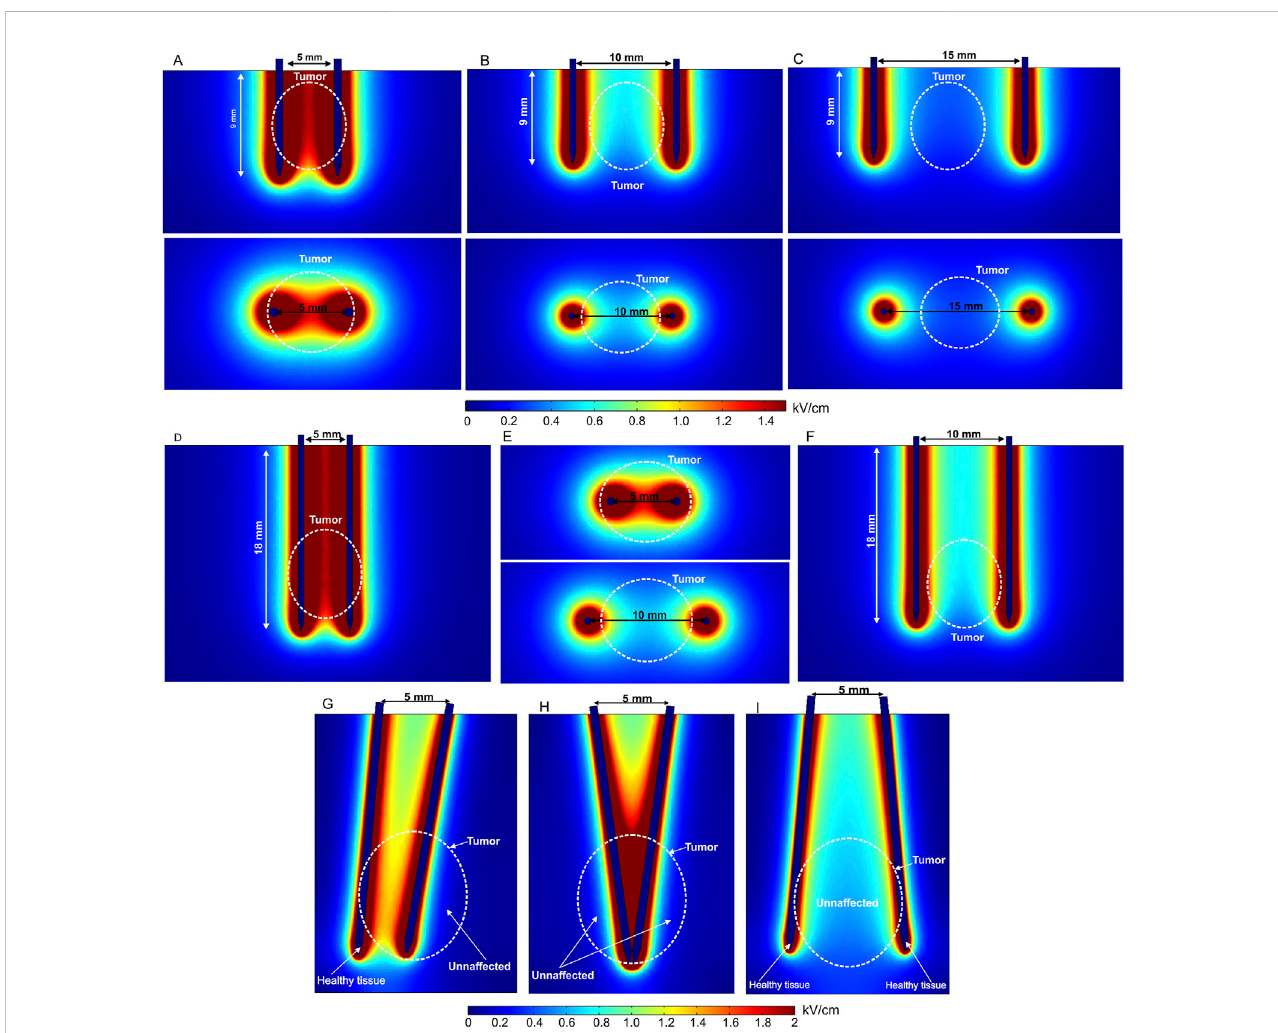
Spatial electric fi eld distribution of two-needle fi xed-position electrodes (A – F) and non-parallelism issue with adjustable electrodes (G – I) with different lengthsandgapsize,using500 Vterminalvoltage: (A) 5mmgapbetweenelectrodes; (B) 10mmgapbetweenelectrodes; (C)